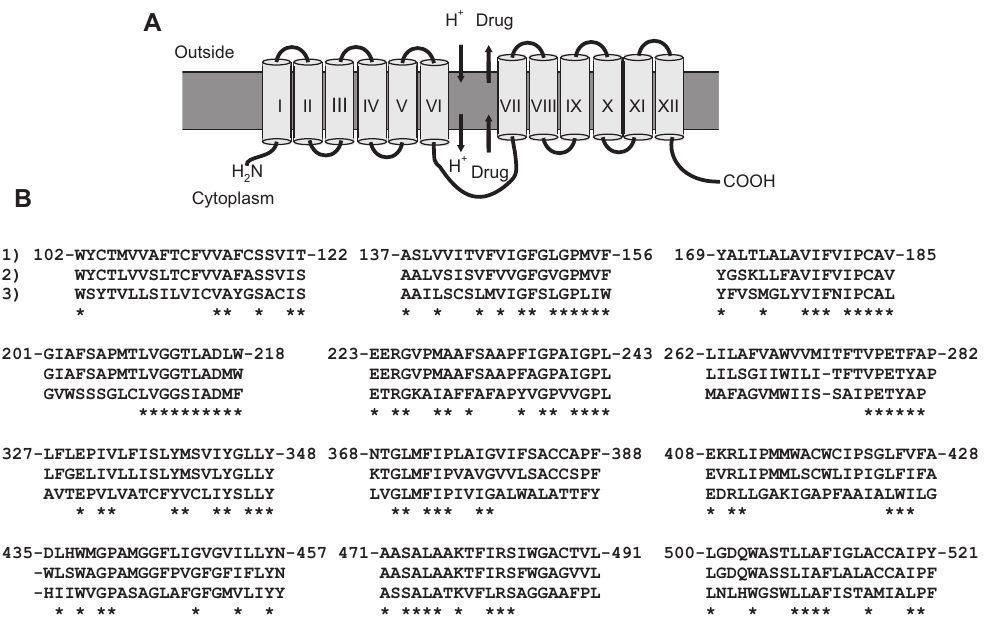
Figure 1 Model of the 12-TMS drug/H + antiporters in cytoplasmic membranes. (A) Note the cytoplasmic loop between TMS VI and VII that has been proposed to be involved in drug binding (101). (B) Alignment of the amino acids included in the 12 TMS of (1) PaaT of P. chrysogenum , (2) CefT of A. chrysogenum , and (3) TPO2 of S. cerevisiae (see text for details). The amino acid numbers correspond to the position in the PaaT protein of P.